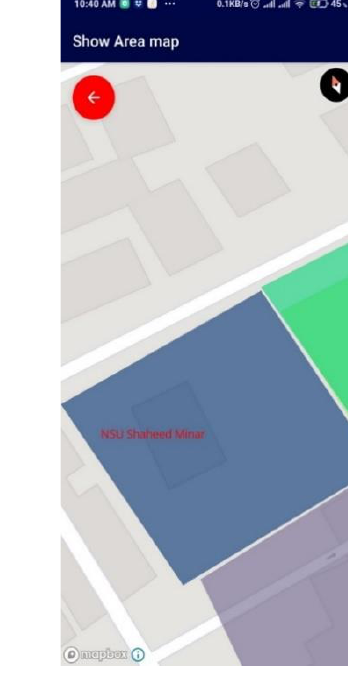
Figure 12. Surface map creation of an Institution ( a ) by selecting an area, ( b ) setting a name of the chosen location, and ( c ) displaying created map, which is visible to all users.